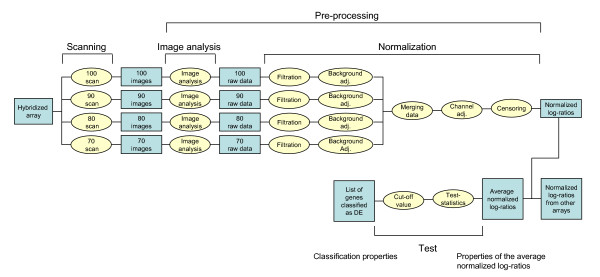
Description of the evaluation study. Theevaluation study was based on raw data from eight Lucidea arrays (Figure 2). All arrays were scanned at four settings and image analysis was applied to extract raw data. The data were normalized in five steps. Filtration and background adjustment were applied to each of the raw data sets. Three procedures for filtration and two procedures for background adjustment were considered. In the third step, data from the four scans were "merged" together. Seven merging procedures were considered; four of these were single scan procedures that used only data from a single scan. Two procedures for channel adjustment and four censoring approaches were considered. In total, 252 unique analyses were conducted. For each analysis the normalized log-ratios were used to conduct a test that generated a list of genes classified as DE. Properties of the average normalized log-ratios and the analyses' classification properties were used to characterize and evaluate the analyses.